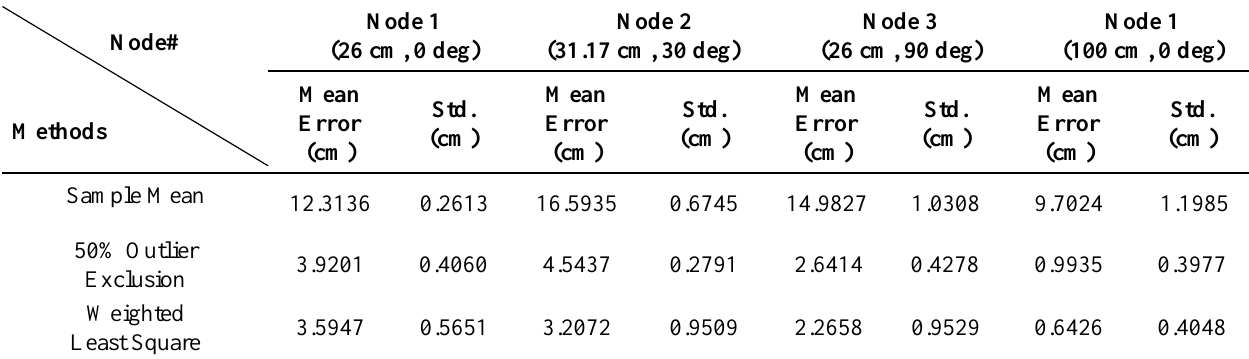
Table 4. The mean error and standard deviation of the repeated